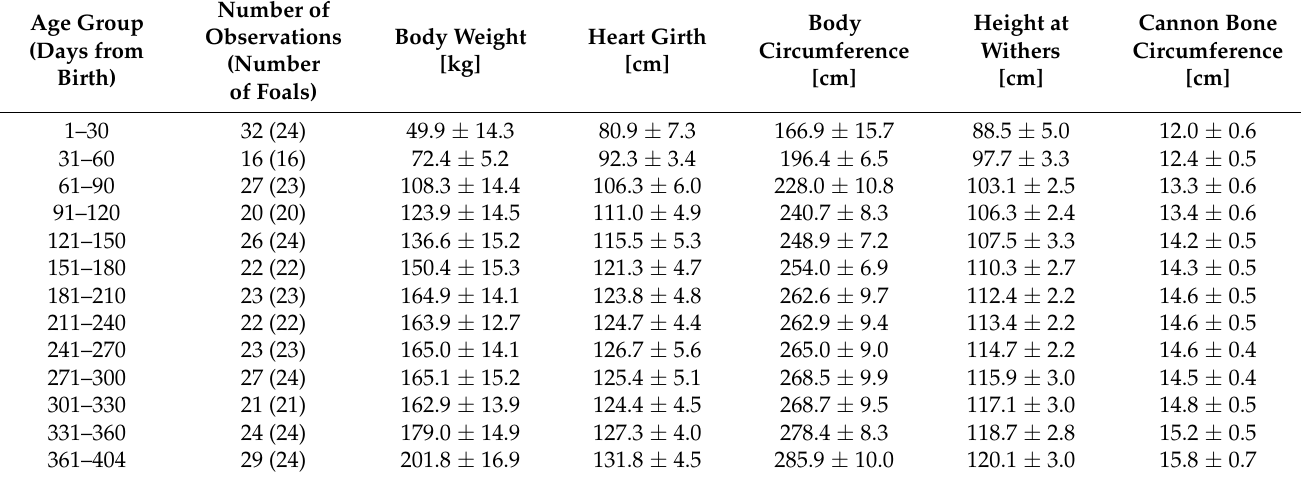
Table 1. The growth variables defined for Icelandic foals, summarized as mean values and standard deviations according to age